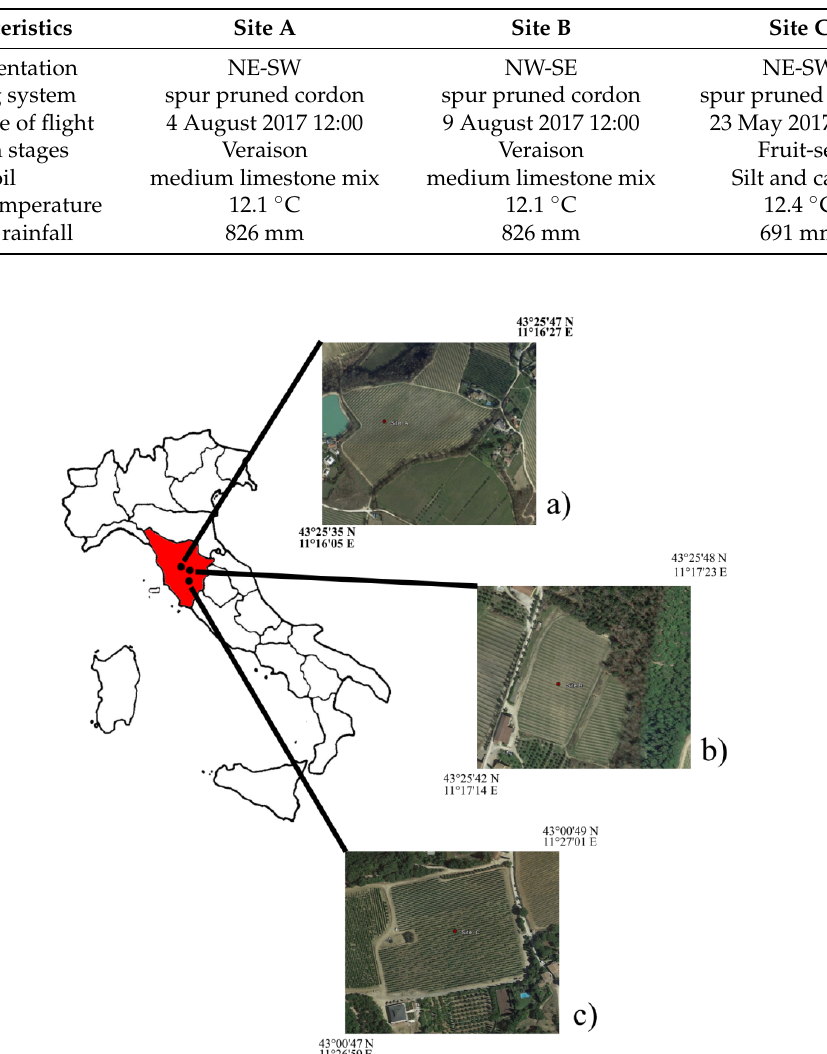
Figure 1. Location map. ( a ) Site A Chianti Classico; ( b ) Site B Chianti Classico; ( c ) Site C Montalcino.